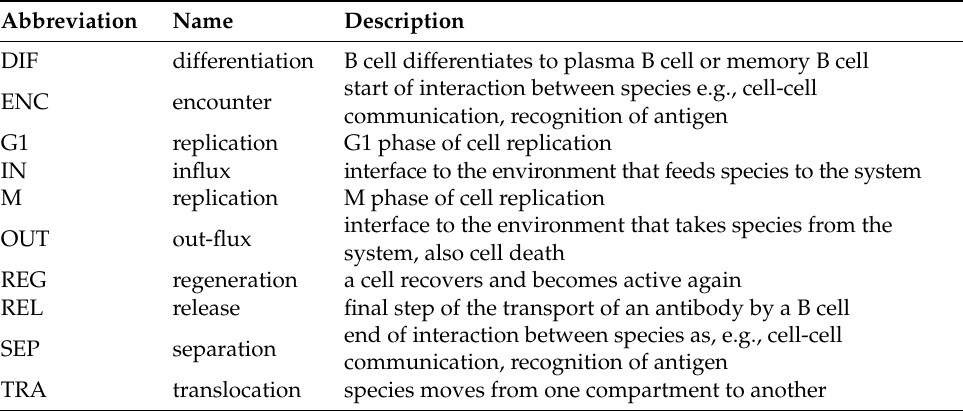
Table 3. Abbreviations for the types of reactions and